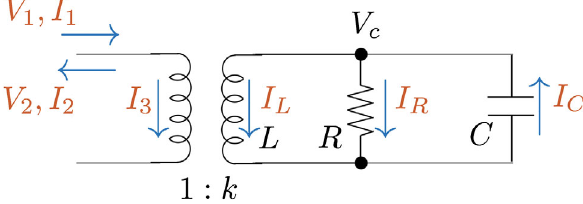
FIG. 22. Definition of the currents and voltages in the equiv- alent circuit of the cavity with a power